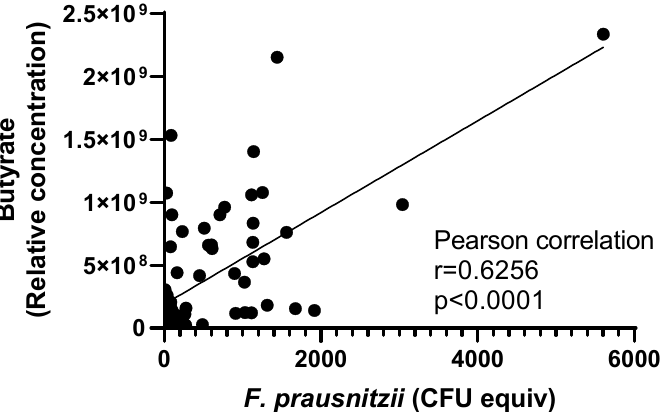
Figure 6. Relationship between butyrate and the amount of F. prausnitzii in batch fermentation experiments. Signals of butyrate were extracted from 1 HNMR metabolomics as expressed as relative concentration and the amount of F. prausnitzii was determined with qPCR technique shown as CFU equivalent (equiv). Data were pooled from 6, 24, and 48 h time points with all treatment groups in all four donors. Each ( • ) corresponds to a sample taken from the in vitro fermentation experiment. Pearson correlation analysis indicates a positive relationship between the number of F. prausnitzii and butyrate ( p < 0.0001, r = 0.6256).